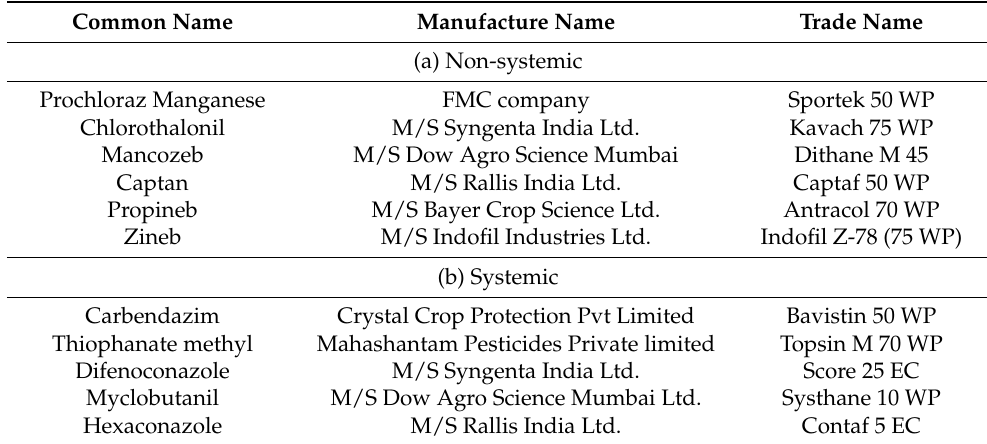
Table 1. Fungitoxicants evaluated against the green mold pathogen of white button mushroom ( A. bisporus